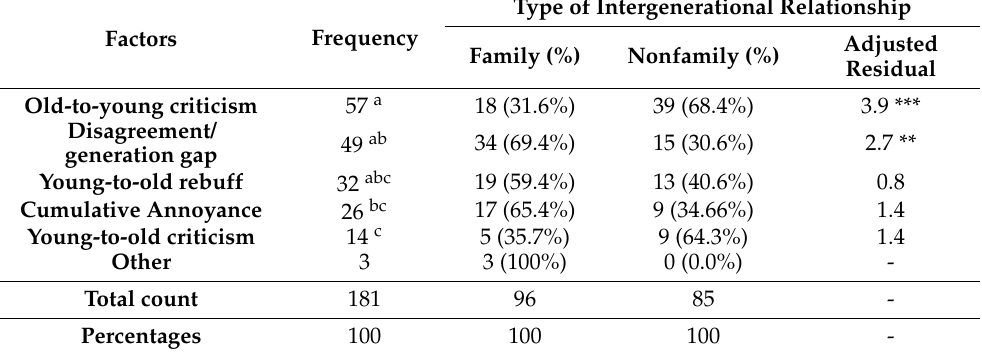
Table 3. Frequencies of the identified conflict-initiating factors in family and nonfamily intergenera- tional